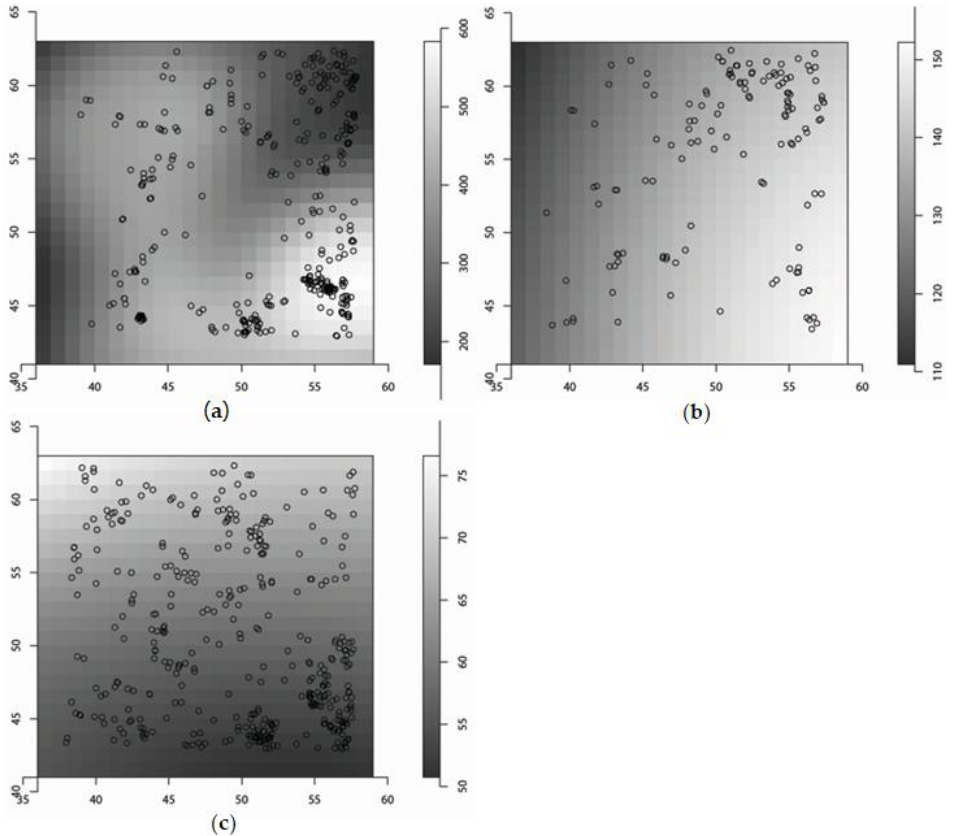
Figure 3. Seed density (gray shades, seeds m − 2 ) and tree seedlings <50 cm height (black circles) for Fagus sylvatica ( a ), Picea abies ( b ) and Abies alba ( c ). Note that the scales are different for the three graphs.